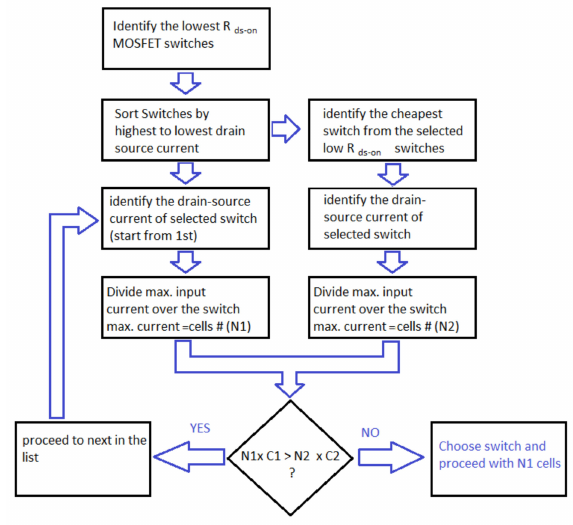
Figure 14. Procedure for cell/switch